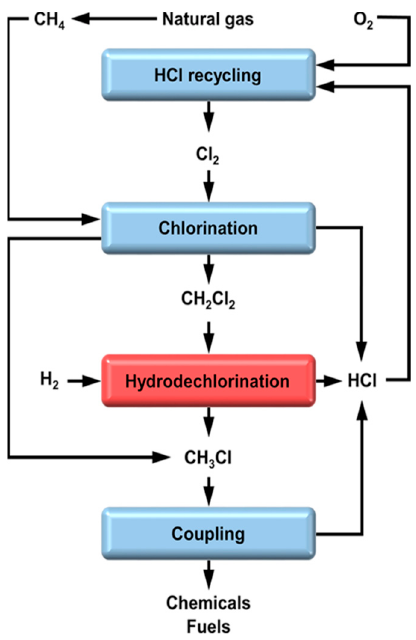
Figure 6. Simplified process flow diagram of valorization of methane using MCM and DCM as intermediates. Reprinted with permission from ref. [45].